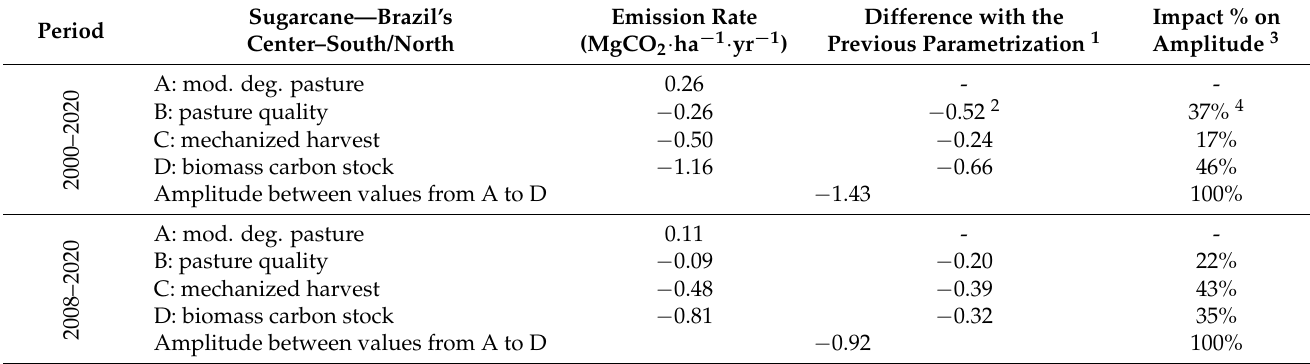
Table 2. Sugarcane emission rate in each parametrization step for the center–south/north region of Brazil based on the LUC; the difference between rates; and the effects of each parametrization on the range of values from A to